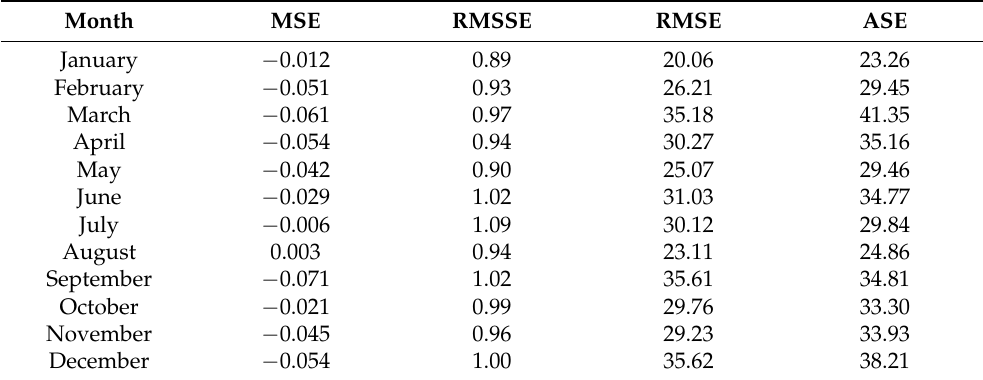
Table 2. Cross-validation statistics for monthly precipitation in the upper Potenza River basin from 2005 to 2020, MSE: mean standardized error, RMSSE: root mean square error standardized, RMSE: root mean square error, ASE: average standard error.